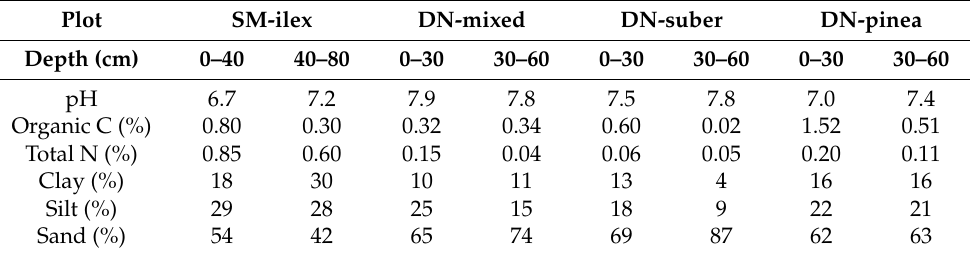
Table 1. Soil characteristics per plot and depth. Soil analysis performed according to: pH [39], organic C [40], total N (Elemental analyzer—measuring the total amounts of nitrogen, carbon and Sulfur (CNS methodology)—Trumac, LECO Corporation, St. Joseph, MI, USA) and texture [41]. Plot